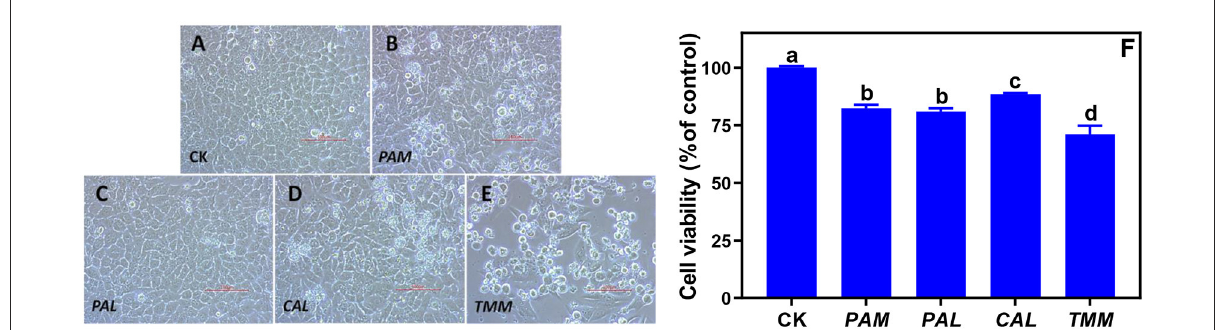
FIGURE3 Alterations of HGEC morphology and viability after being exposed to the extracts of wild vegetables for 24h. Normal HGEC morphology in control ( A ; CK) and altered cell morphology and viability after exposures to the extracts of PAM (B) , PAL (C) , CAL (D) , and TMM (E) . Cell viability was determined by the CCK-8 assay kit and was normalized as the percentage of control (F) . Typical cobblestone, round, or floated appearances of HGEC were clear in the control group and exposure groups (A–E) at 200 × magnification (bar = 100 µ m). Error bars represent the mean ± SD of values from triplicate experiments. Different letters indicate significant differences ( p < 0.05).